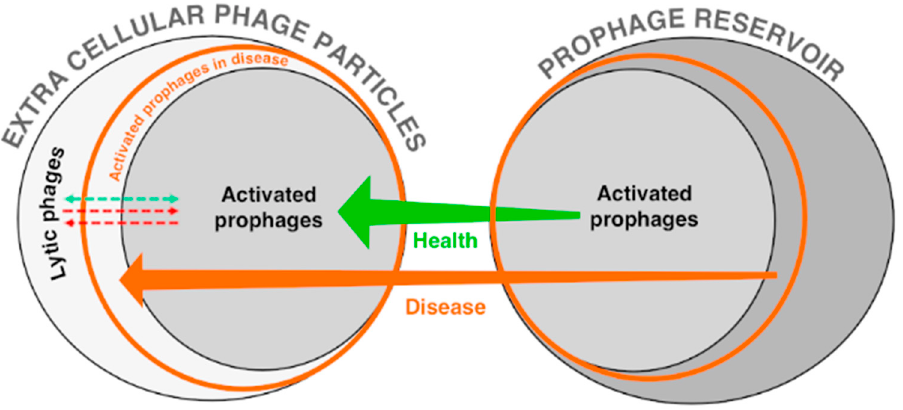
Figure 3. The adult gut phage community in health and disease. Bacteriophages found in human stool are an ensemble of lytic phages and activated prophages that arise from a larger prophage reservoir found in the gut microbial community. It has been proposed that the increase in phage diversity in inflammatory bowel disease patients comes from activation of a larger fraction of the prophage reservoir, which in turn leads to a decrease in bacterial diversity [11]. An increase of lytic phages has also been correlated with disease [60], suggesting that a proper balance between lytic phages and activated prophages is important to maintain health.